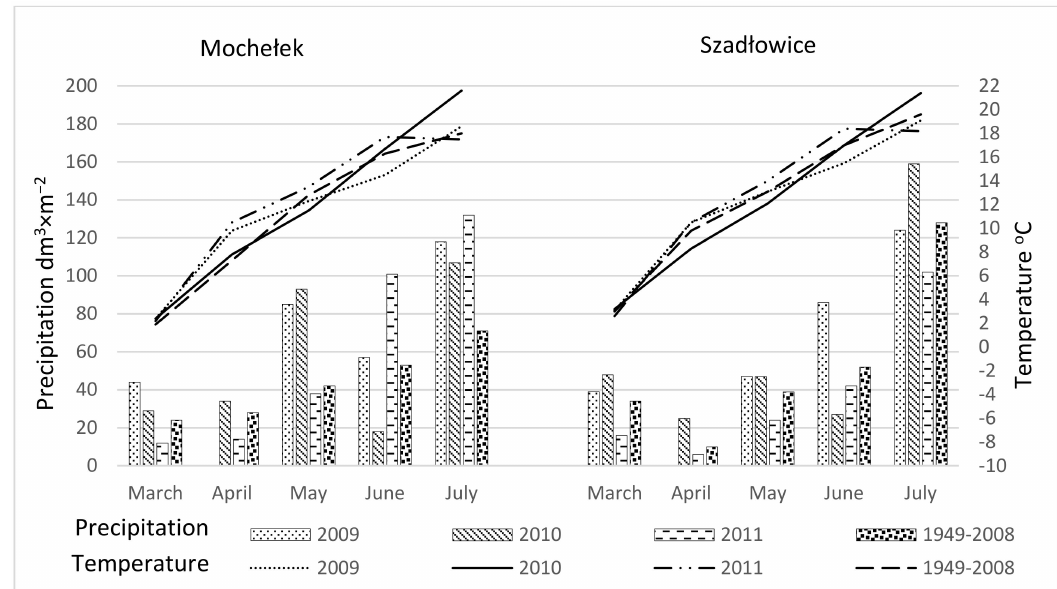
Figure 3. Precipitation and air temperature (2009 to 2011) during spring barley